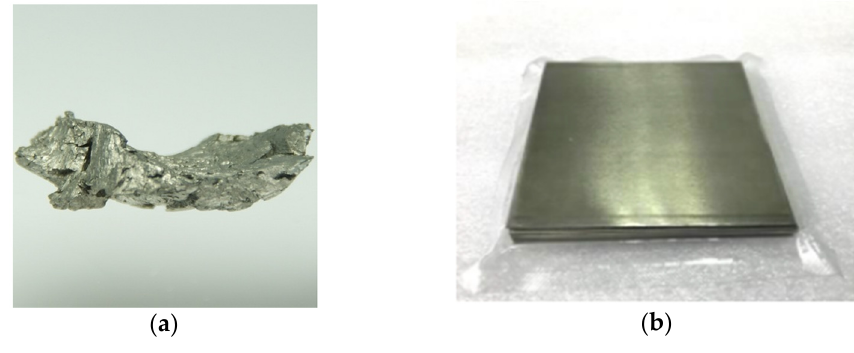
Figure 1. Picture of Gd: ( a ) metal [14] and ( b ) plates [15]. To increase the temperature differences, it is necessary to develop devices that will perform AMRR cycles. This regenerator exchanges heat with a crossing fluid that circulates between two external heat sources (cold and hot). This heat transfer between these lasts increases the difference of their temperature. This type of cycle is called AMRR cycle